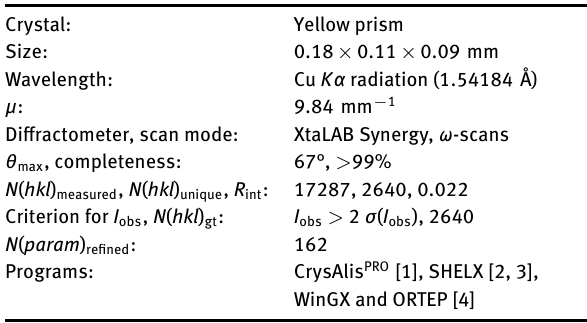
Table 1: Data collection and handling. Crystal: Yellow